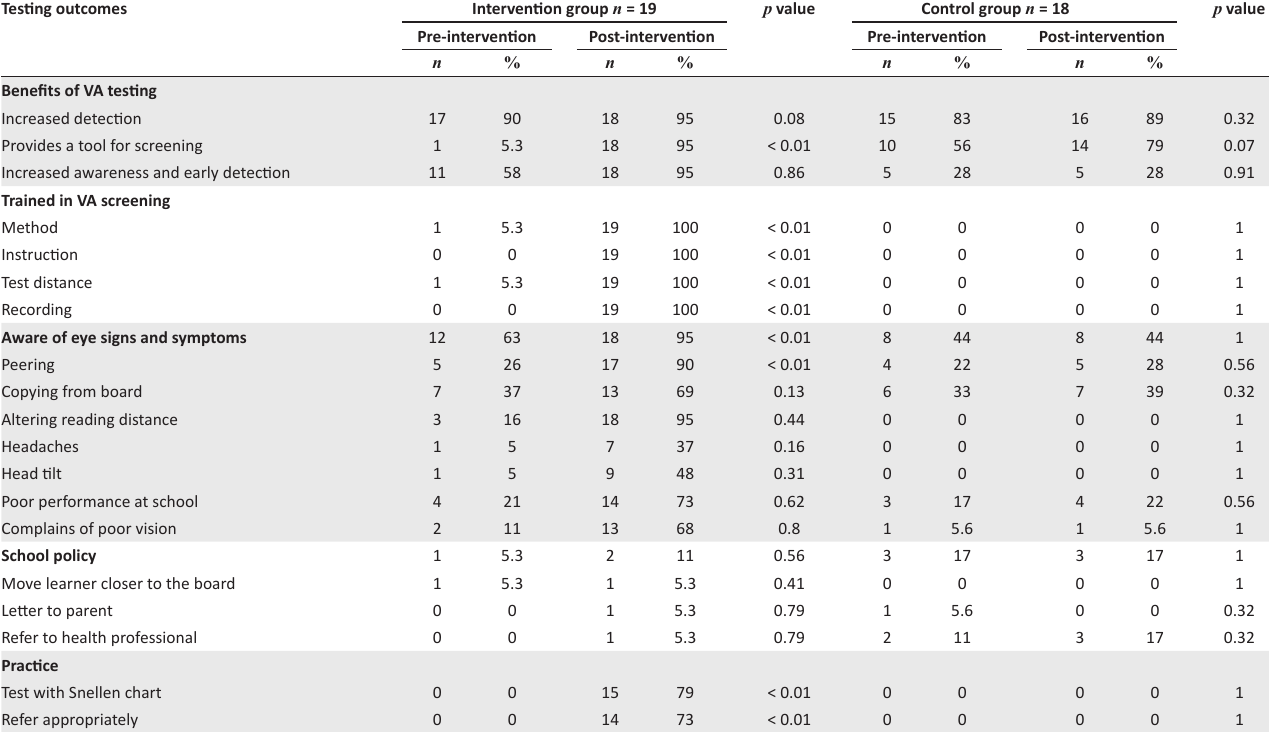
TABLE 2: Outcomes of the intervention and control group for knowledge and practices of visual acuity screening of Grade 5 educators in Chatsworth primary schools in 2013. Testing